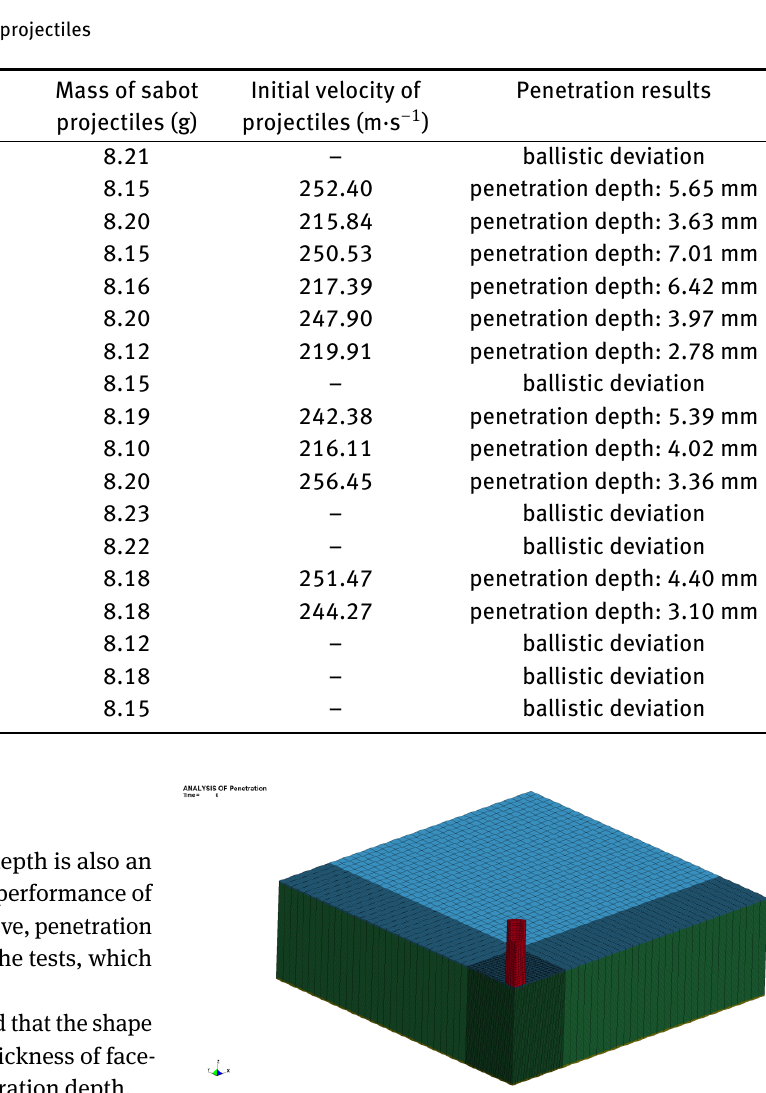
Figure 8: Finite element model of steel/nylon sandwich